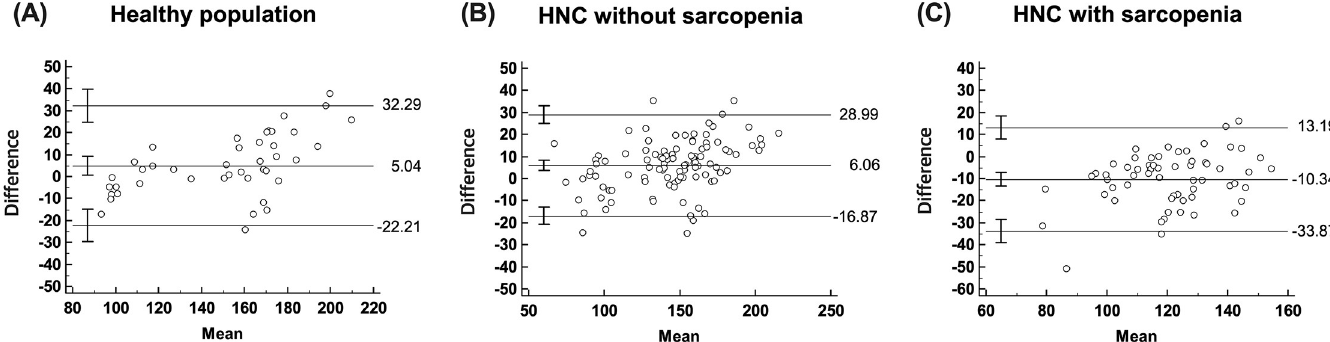
Fig 5. Bland-Altman plot showing the difference against the mean of actual and predicted L3 skeletal muscle masses in each group. Lines indicate the mean and the limits of agreement. HNC, head and neck cancer.